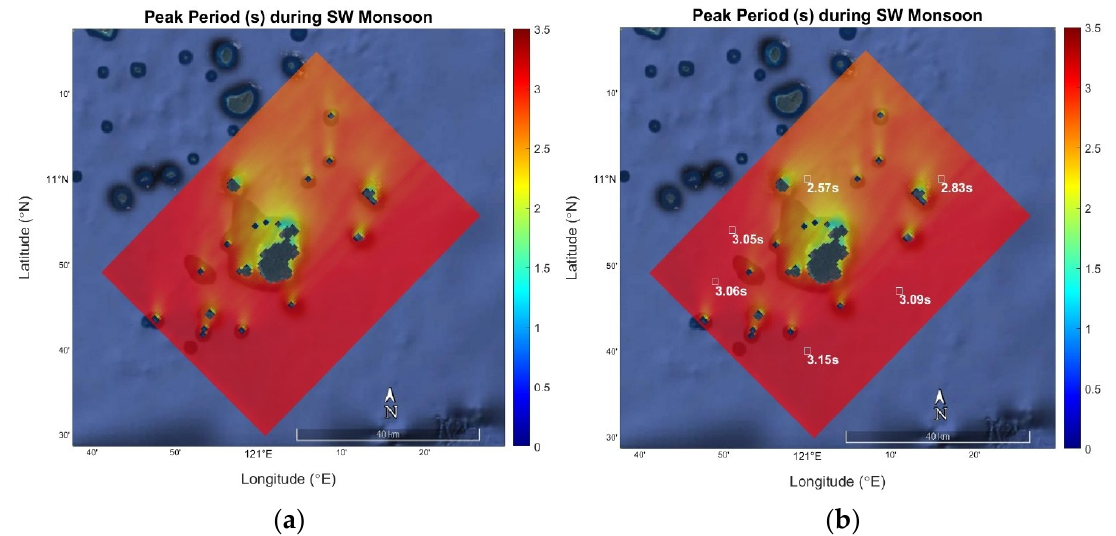
Figure 20. ( a ) T p (s) model during southwest monsoon season and ( b ) T p model indicating the average T p at stations A–F.